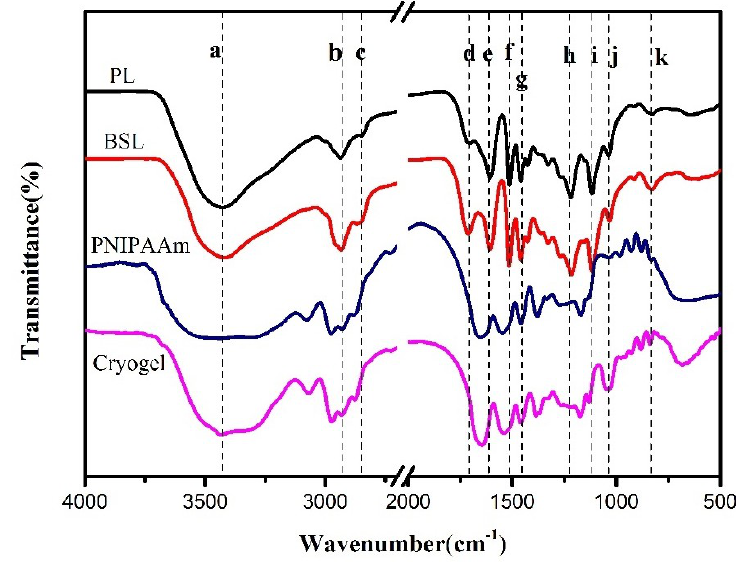
FTIR spectra of purified alkali lignin (PL), 1-butanol soluble lignin (BSL), poly( N -isopropylacrylamide) (PNIPAAm), and cryogel (mass ratio, 1:24).